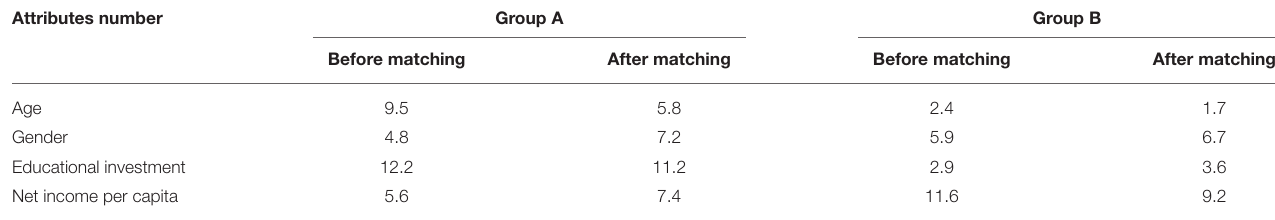
TABLE 3 | Standardized deviation distribution of control variables before and after model matching.